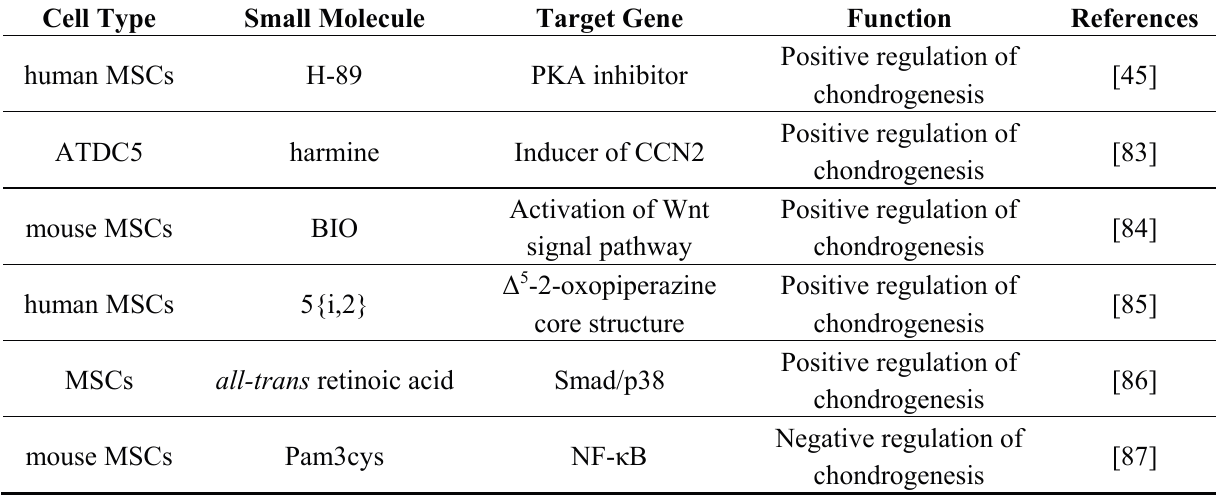
Table 2. Summary of chondrogenic differentiation by small